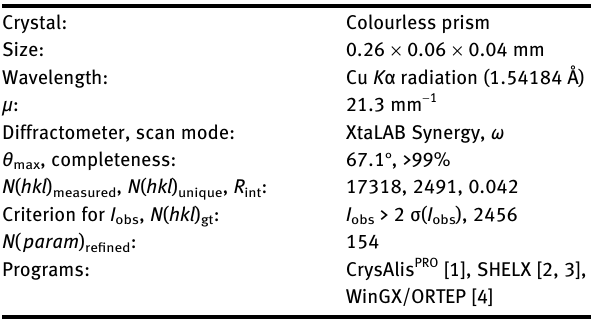
Table  : Data collection and